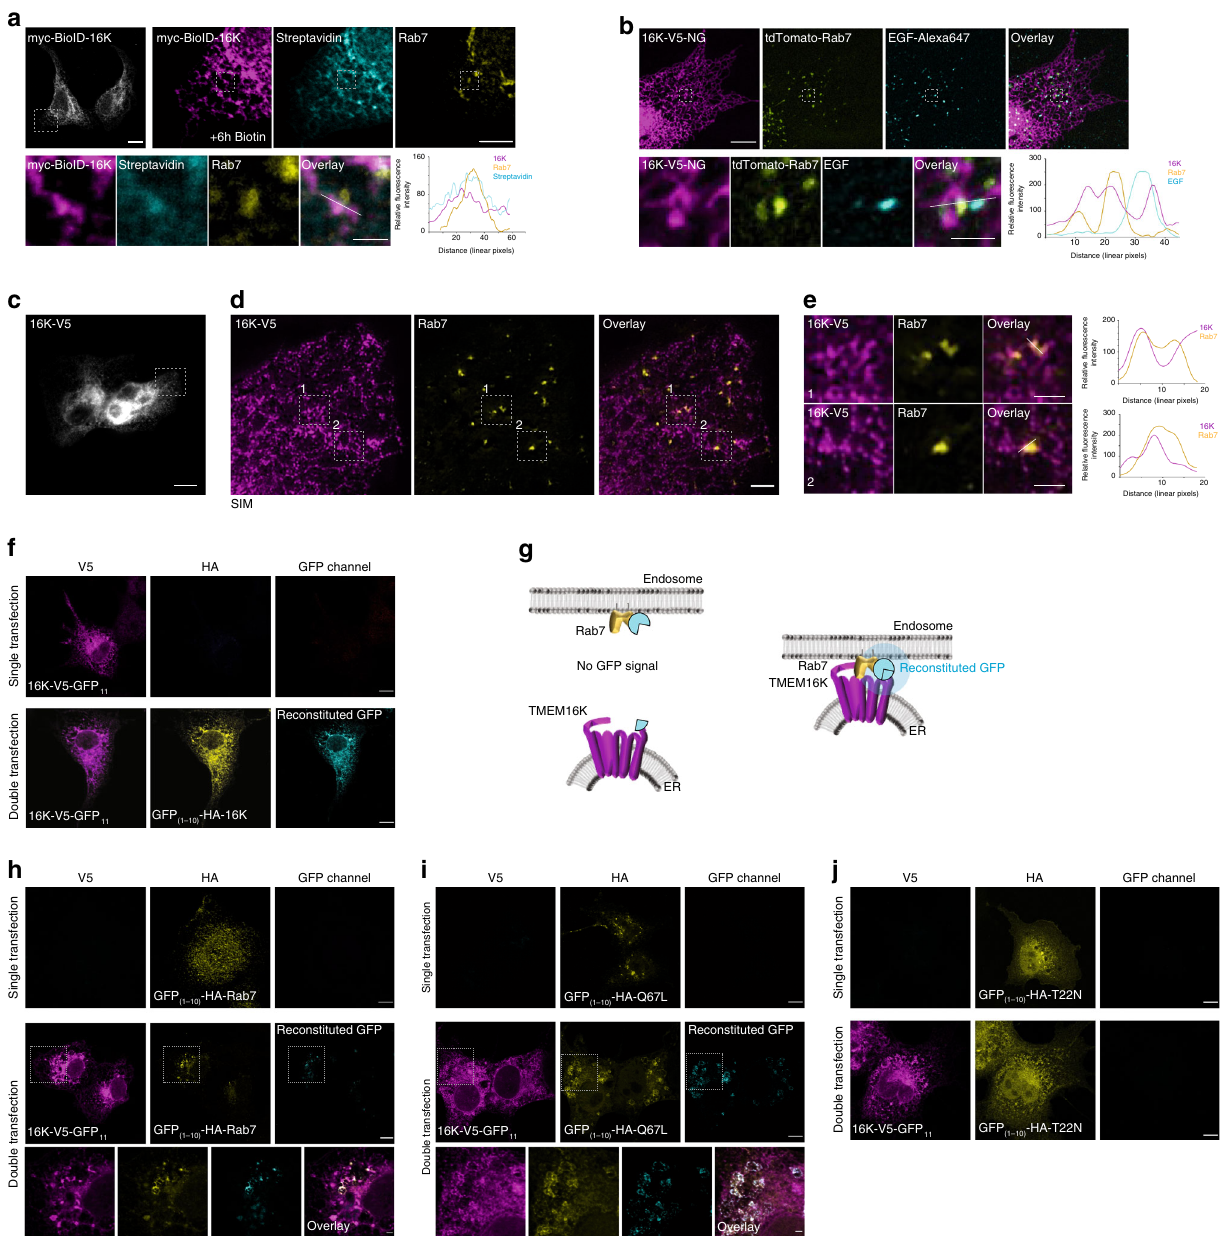
Fig. 5 TMEM16K at ER-endosome membrane contact sites. a Immunocytochemistry to visualize TMEM16K proximity labeling of endosomes. COS-7 cells were transfected with TMEM16K tagged with proximity biotinylation enzyme, incubated with biotin for 6 h, and immunostained with fl uorescently conjugated Streptavidin and antibody against endogenous Rab7. a . Row 1, Left: View of the entire cell expressing myc-BioID-TMEM16K. Scale bar 10 µ m. a . Row 1, Right: Magni fi ed region of the cell showing myc-BioID-TMEM16K, its pattern of proximity biotinylation and endogenous Rab7. Scale bar 5 µ m. a . Row 2: High magni fi cation insets with line scan quanti fi cation of the three channels marked in overlay. Scale bar 1 µ m. b Live imaging of the U-2OS cells transfected with TMEM16K-V5-mNeonGreen (TMEM16K-V5-mNG), tdTomato-Rab7, and EGF-Alexa647, pulse chased for 45 min, imaged with spinning disk confocal microscope. See Supplementary Movie 3. b Row 1: Snapshots of the live imaging showing TMEM16K, Rab7, EGF and their overlay. Scale bar 10 µ m. b . Row 2, High magni fi cation insets with line scan quanti fi cation of the three channels marked in overlay. Scale bar 0.5 µ m c Wide fi eld image to view entire cell expressing TMEM16K-V5. Scale bar 10 µ m. Inset marks cell region imaged with structured illumination microscopy (SIM). d . Single plane structured illumination microscopy of U-2OS cells transfected with TMEM16K-V5 and immunolabelled for endogenous Rab7. Scale bar 2 µ m. e High magni fi cation insets 1 and 2 from SIM images with corresponding line scan quanti fi cation of the two channels marked in overlay. Scale bar 1 µ m. f Split-GFP assay positive control with cells transfected with TMEM16K-V5-GFP and GFP (1 – 10) -HA-TMEM16K, as TMEM16K acts as dimer. Scale bar 10 µ m. g Scheme of the split-GFP experiment where molecule of the GFP can be reconstituted only if the two proteins contact. h Split GFP reconstitution assay between TMEM16K-V5-GFP and GFP (1-10) -HA-Rab7. Scale bar 10 µ m, inset 2 µ m. i Split-GFP reconstitution assay betweenTMEM16K-V5-GFP 11 and constitutively active mutant of Rab7 Q67L tagged with GFP (1 – 10) Scale bar 10 µ m, inset 2 µ m. j Split-GFP reconstitution assay between TMEM16K-V5-GFP 11 and inactive mutant of Rab7 T22N tagged with GFP (1 – 10) Scale bar 10 µ